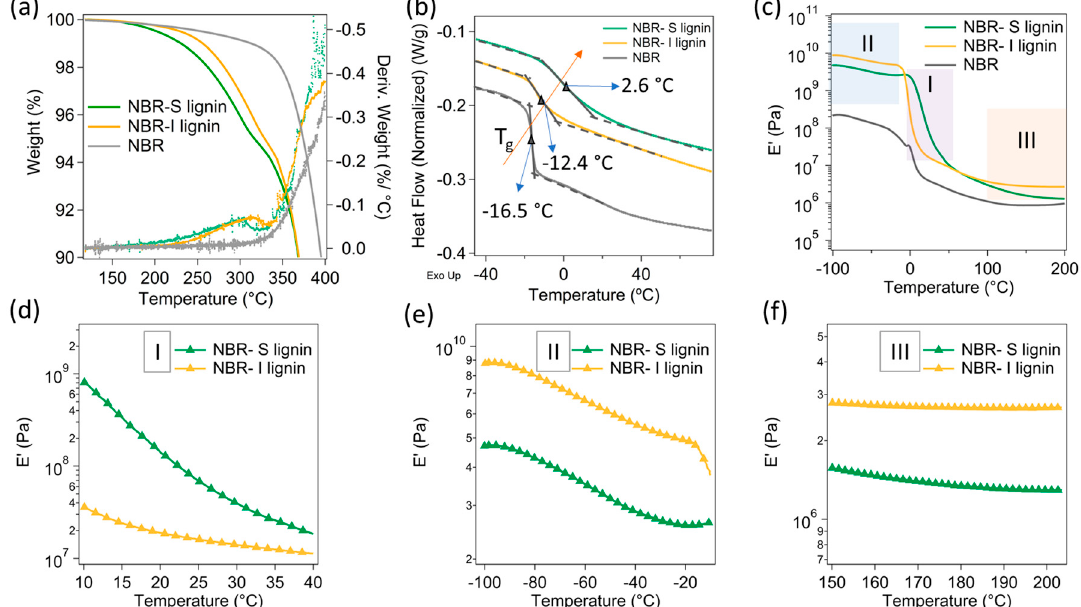
Figure 4. Thermal and dynamic mechanical characteristics of pristine NBR and 50 wt.% NBR–S lignin and I lignin samples: ( a ) TGA: the solid lines are the weight loss as a function of temperature, the dotted lines are the derivative weight loss; ( b ) DSC; ( c ) Temperature dependent modulus (E’); and ( d – f ) the corresponding zoomed-in modulus at di ff erent temperature